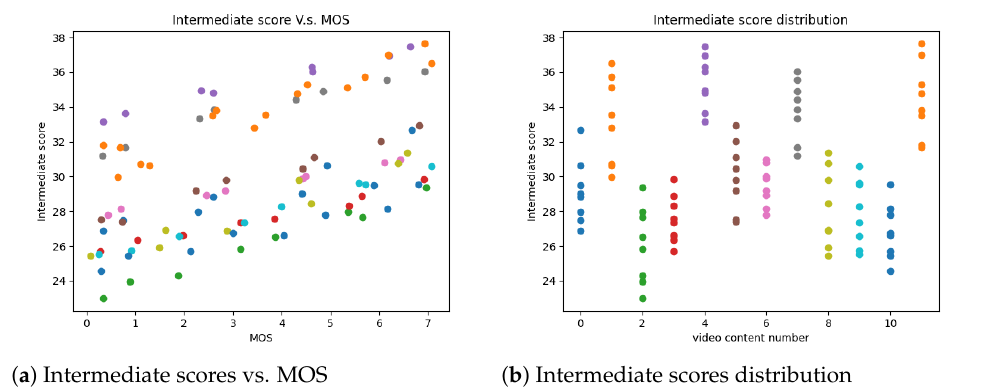
Figure 3. Statistical analysis.